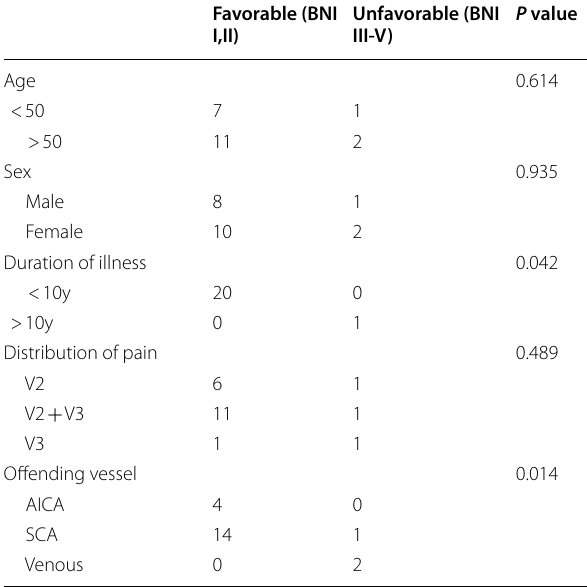
Table 5 The univariate analysis of factors potentially associated with pain control outcomes in